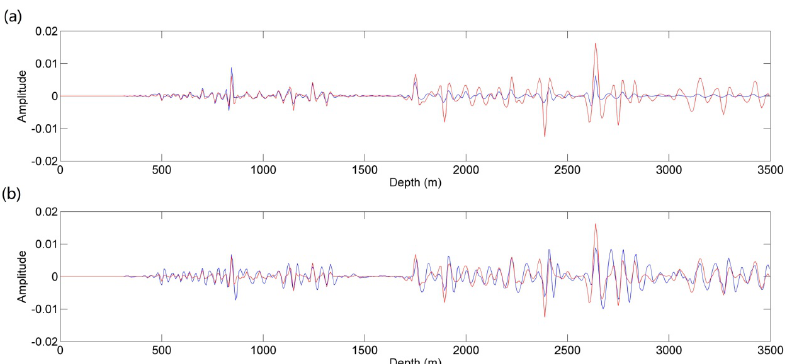
Figure 8. ( a ) Comparison of the imaging amplitudes of RTM (blue line) and the theoretical amplitudes (red line) at log L1; ( b ) Comparison of the imaging amplitudes of our proposed method (blue line) and the theoretical amplitudes (red line) at log L1.